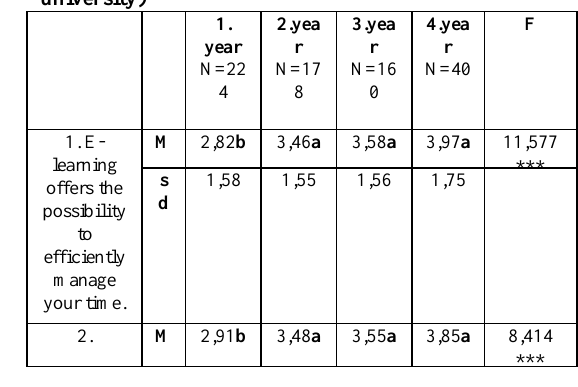
Table 5.Anova results for Grade (Year at